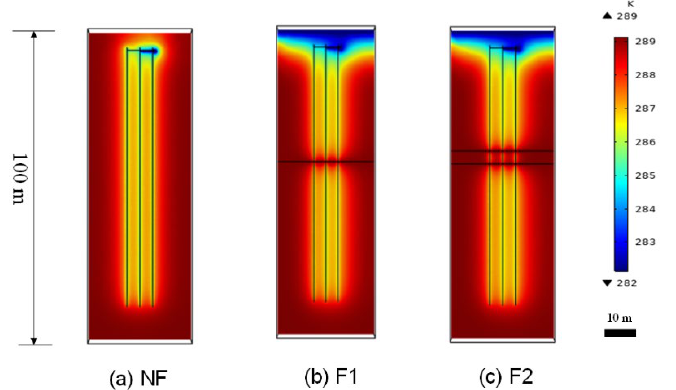
Figure 10. The temperature field in the Y-Z plane at X = 20 m at the 26th month: (NF) rock mass without cracks; (F1) one horizontal crack; (F2) two horizontal